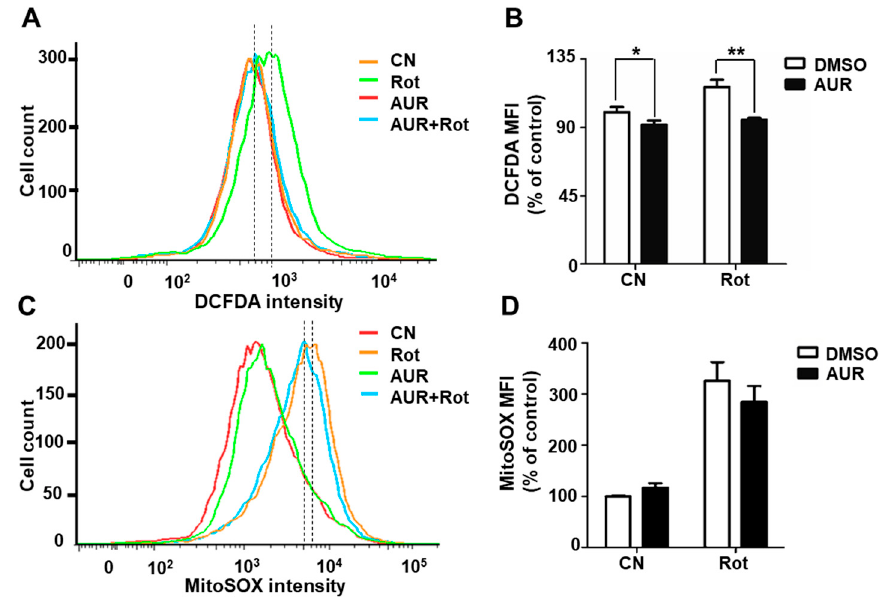
Figure 3. AUR protects against rotenone-induced ROS production. ( A – D ) SN4741 cells were incubated with rotenone (Rot) for 6 h, with or without AUR pretreatment for 1 h. Cells were stained with DCFDA or MitoSOX ™ , and fluorescence intensity was measured by flow cytometry. Total ROS was determined by measuring DCFDA-stained cells ( A , B ), and mitochondrial ROS was determined by measuring MitoSOX ™ -stained cells ( C , D ). Median fluorescence intensity (MIF) values are presented as means ± SD of three experiments (* P < 0.05, ** P < 0.01 vs. corresponding controls). CN, control.